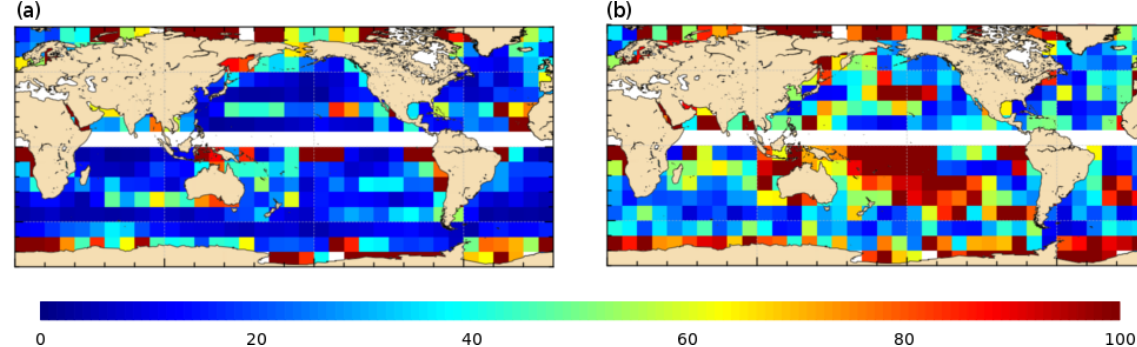
Figure 1. Root mean square differences between (a) zonal and (b) meridional mean geostrophic drifter velocities and the MDT CNES-CLS18 first-guess geostrophic velocities in percentage of drifter variance (%) in 5 ◦ × 5 ◦ boxes.